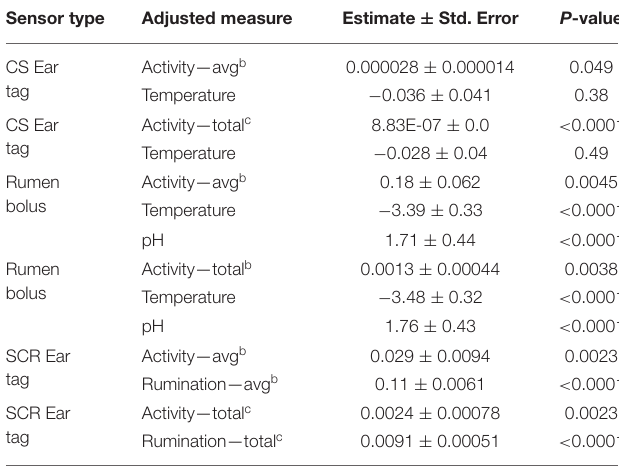
TABLE 6 | Association of sensor measurements a with dry mater intake from models integrating all types of measurements available for a single sensor type. Sensor type